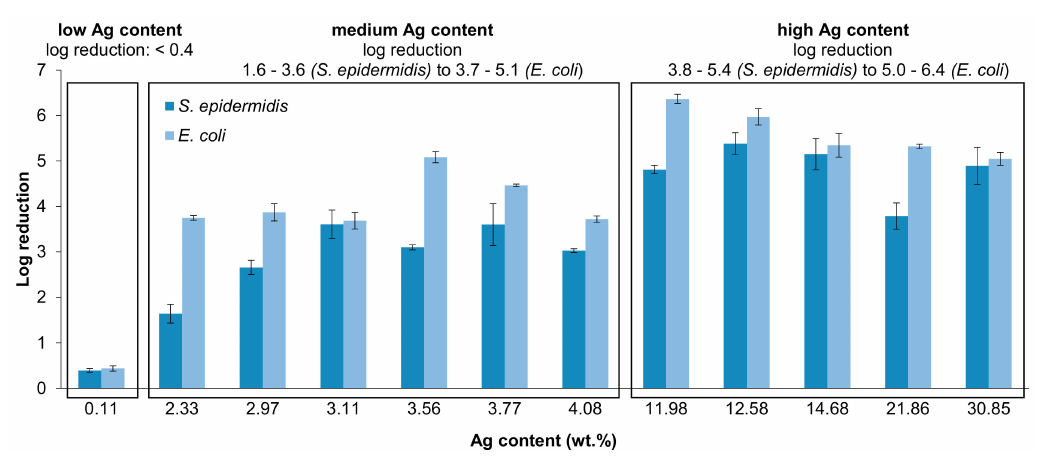
Figure 6. Antibacterial properties of Ag / TNTs with reference to Ag content in the hybrid